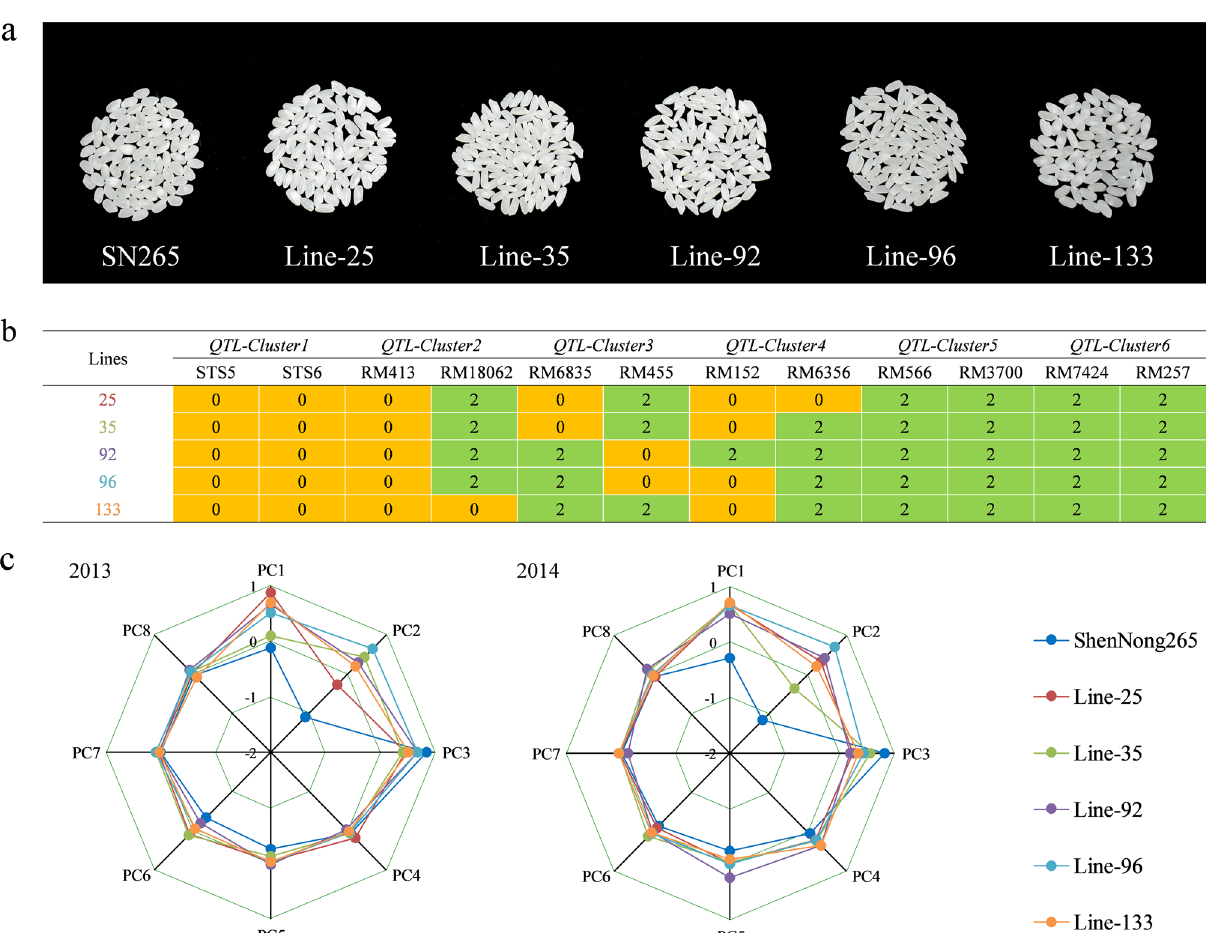
Figure 7. ( a ) Photographs of head rice from SN265 and five excellent quality lines. ( b ) Genetic performance of five excellent quality lines on six QTL clusters, where 0 represents inheritance from SN265 and 2 represents inheritance from LH99. ( c ) Comparison of the scores of SN265 and the five excellent quality lines on the eight principal